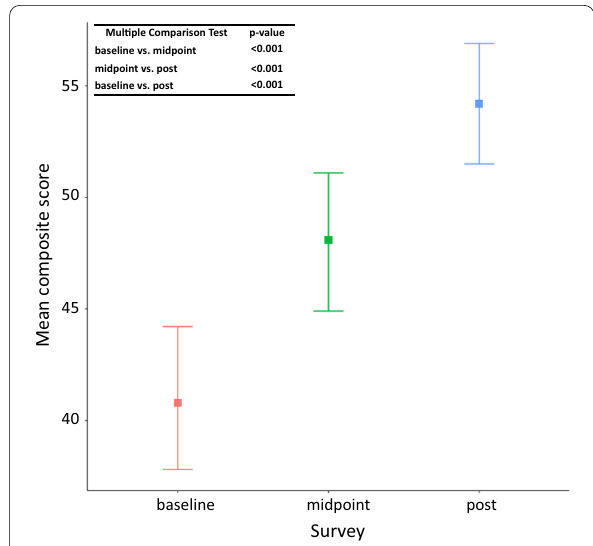
Fig. 2 Repeated measures ANOVA and Tukey multiple comparison tests were conducted to compare participants’ level of competence in mastering 17 skills and practices of science. Participants exhibited significant improvement over three timepoints: (1) baseline to midpoint; (2) midpoint to post-survey; and (3) baseline to post-survey (composite score of the 17 skills and practices; estimate: 48.118; SE 1.576; df 32; t 30.532; p < = =